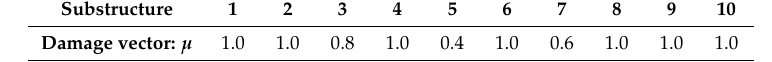
Figure 11. Case 1: identified damage extents.